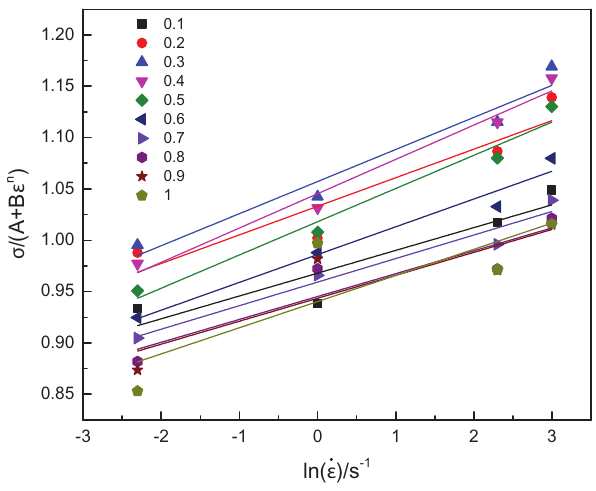
Figure 4: Relationship between ( σ = A + B ε n ð Þ ) and ln _ ε * at the tem- perature of 933 K.